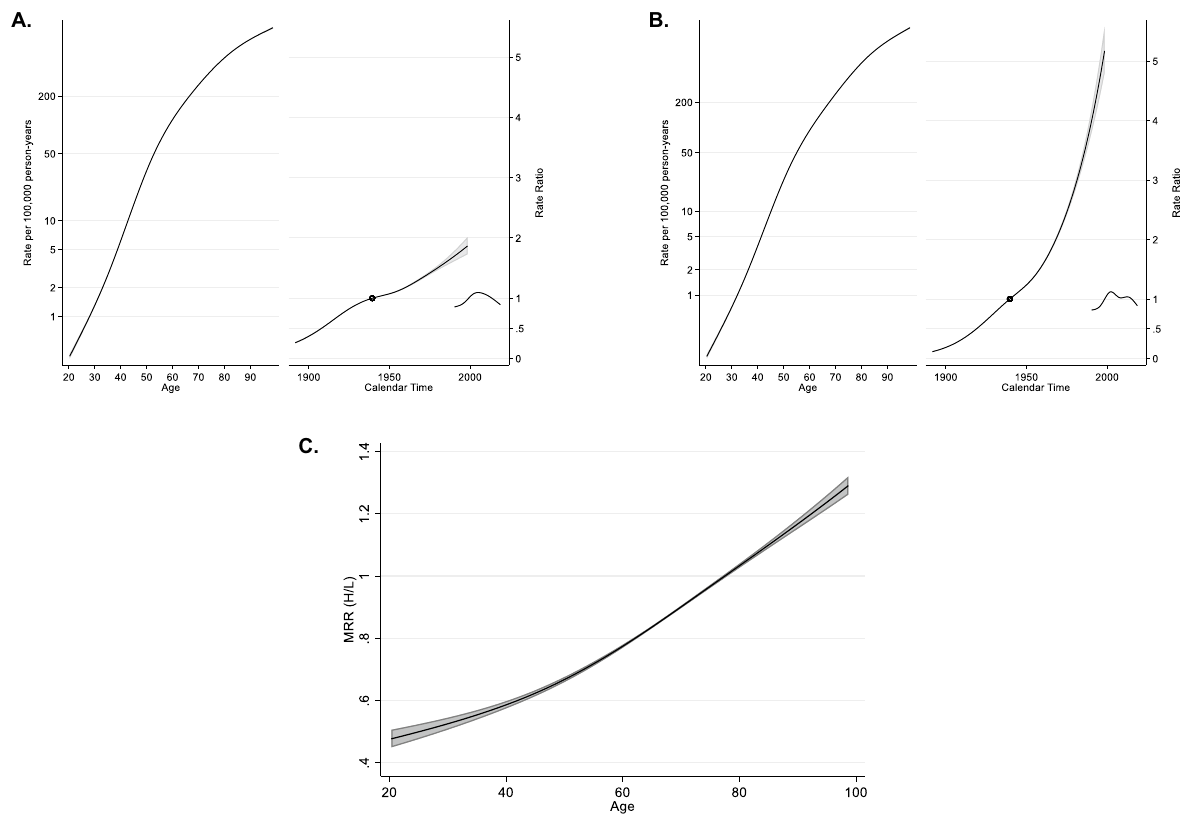
Figure 3. Age-period-cohort analysis for diabetes mellitus mortality rate in the very low and low quintile of marginalization in relation to medium, high and very high in Mexico, 1990–2019. ( A ) The age-period-cohort model for the population with the lowest marginalization (very low and low quintile). ( B ) The age-period- cohort model for the population with the highest marginalization (medium, high, and very high quintiles) between 1990 and 2019. The leftmost solid line is the age effect, the longest of the solid lines on the rate ratio half of the graph is the cohort effect, and the shortest line is the period effect. Finally, ( C ) shows the time- dependent mortality rate ratio for the interaction of the highest marginalization quintiles with respect to the lowest quintiles by age. The shaded gray area indicates the 95% confidence interval. DM diabetes mellitus, MRR mortality rate